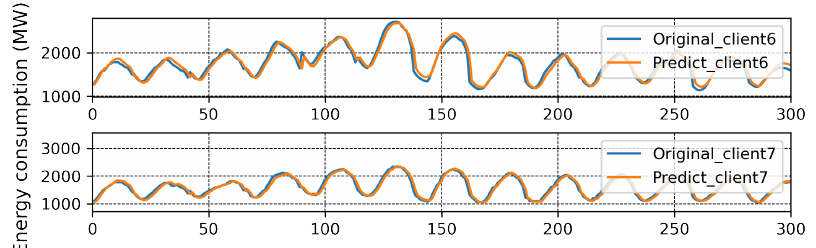
Figure 9. Prediction results of Branch 2.